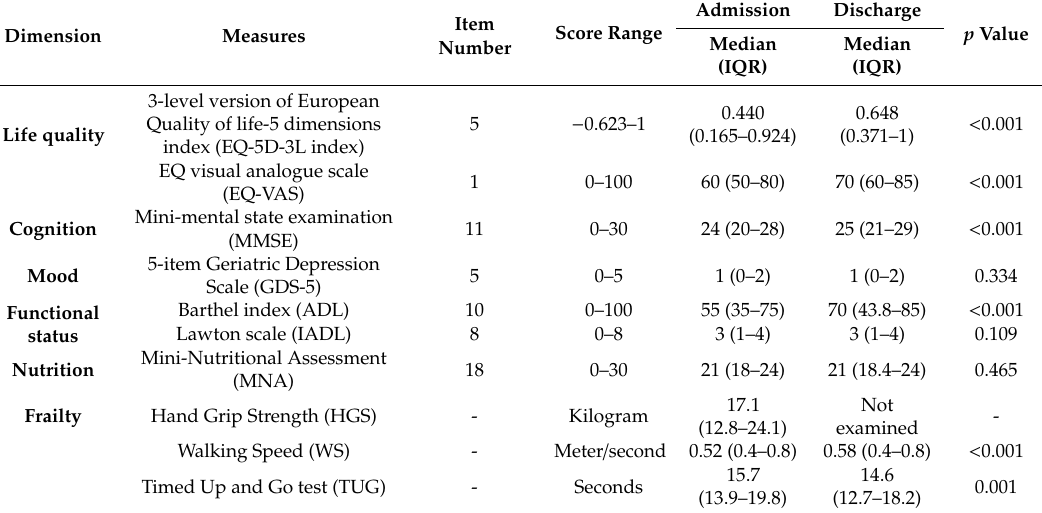
Table 2. Changes of the 3-level 5-dimensional Euro-Quality of Life tool (EQ-5D-3L) index, EQ-Visual Analog Scale (EQ-VAS), and comprehensive geriatric assessment parameters between admission and discharge.